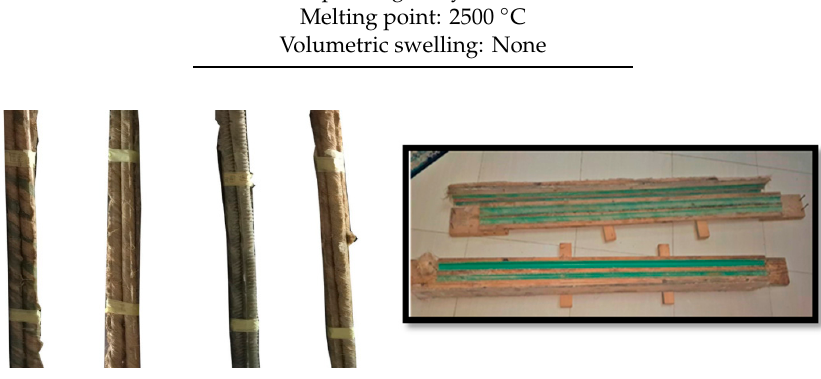
Figure 4. Shapes and manufacturing process of banana fiber bars. Table 2. Phytochemical properties of polyester